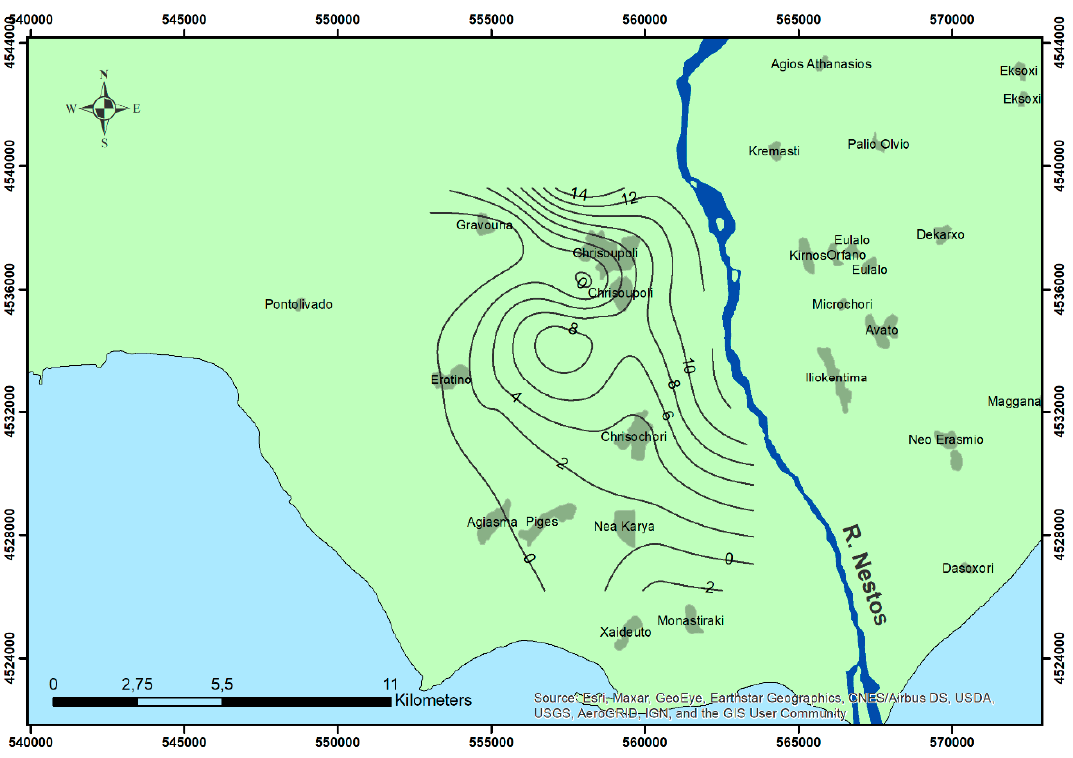
Figure 6. Piezometric map of the unconfined aquifer (October 2019).